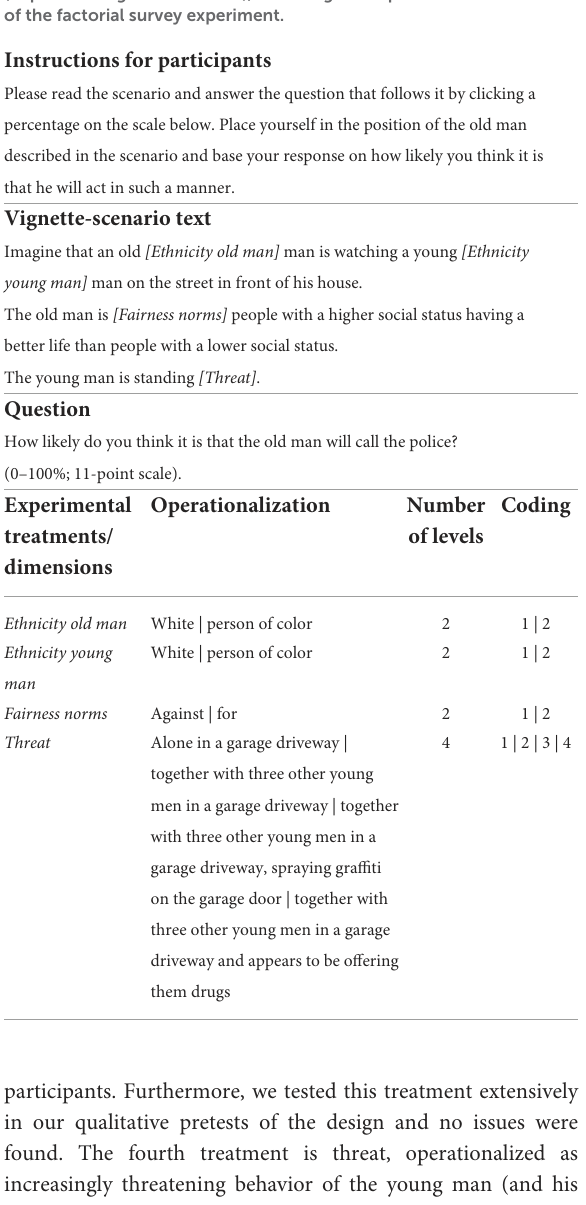
TABLE 1 The vignette-scenario text, the question and the response (dependent vignette-variable), including the experimental treatments of the factorial survey